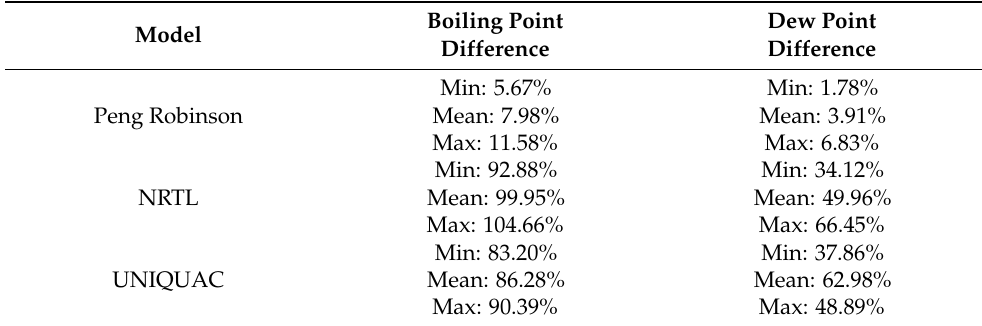
Table 3. Comparison between HYSYS V9 and Aspen Plus